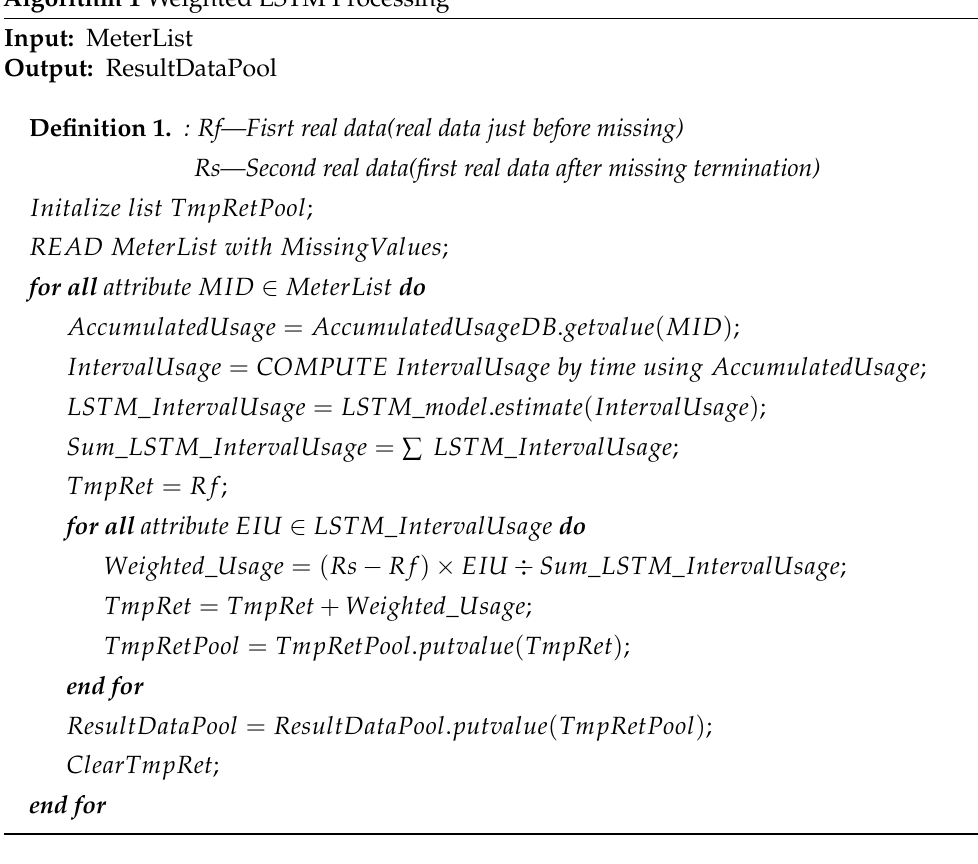
Algorithm 1 is missing data compensation algorithm that applied weighted LSTM